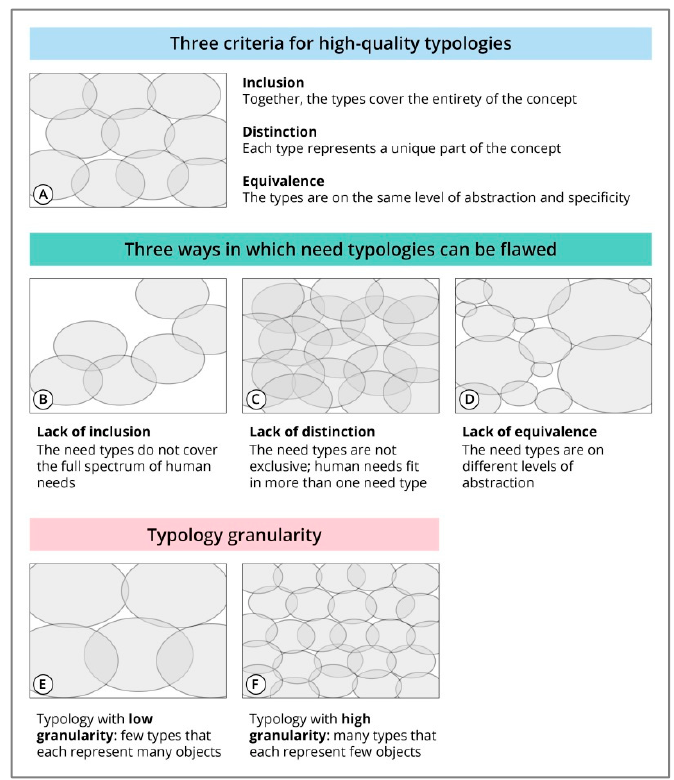
Figure 2. Four criteria for evaluating typologies.